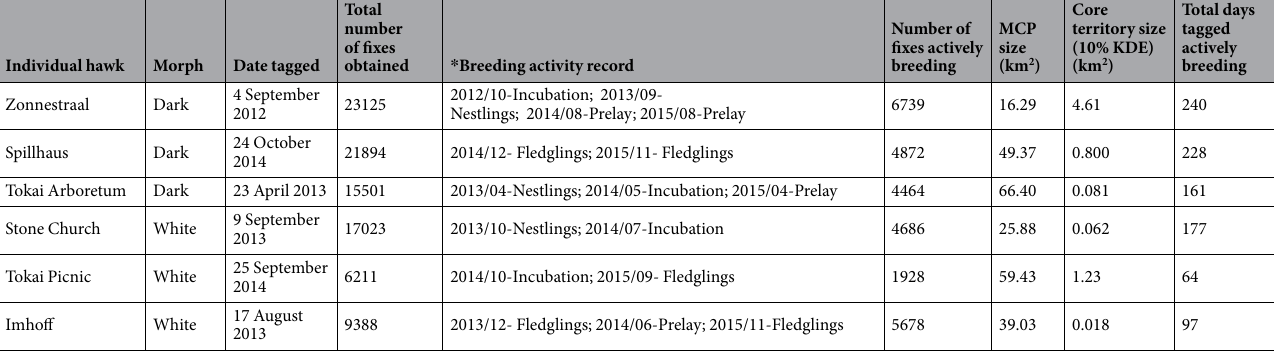
Table 4. GPS tracking details for the six black sparrowhawk males on the Cape Peninsula over 2012-2015. We tagged three dark morph males and three white morph males with solar powered loggers. The table shows different breeding stages recorded for each individual. Individual Multiple Convex Polygons (MCP) and 10% Kernel Density Estimates (KDE) were calculated using GPS data from actively breeding individuals. We also report the breeding activity recorded for each individual and provide information on the dates of the breeding stages recorded and the stage which breeding reached for each breeding